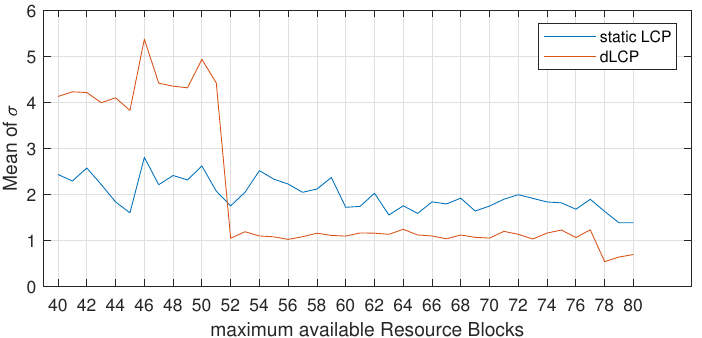
Figure 9. Jitter for TSN Packet Size of 700 bytes.